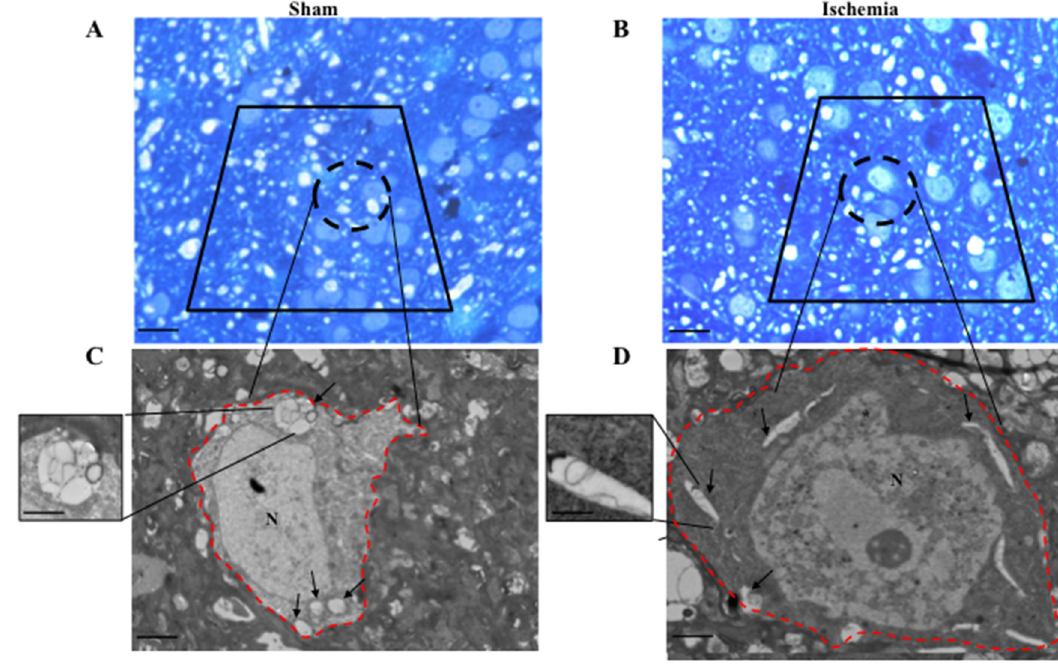
Figure 4. Representative semithin and ultrathin slices. Semithin slice of a brain area from a control sham-operated mouse